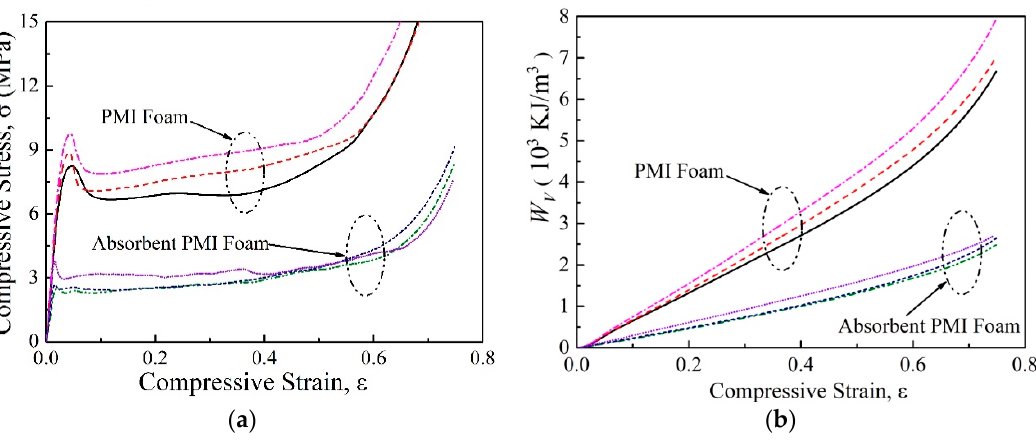
Figure 3. Compressive behaviors of PMI foams. ( a ) Stress strain curve; ( b ) Energy absorption. The ellipse circles indicate classes of specimens.